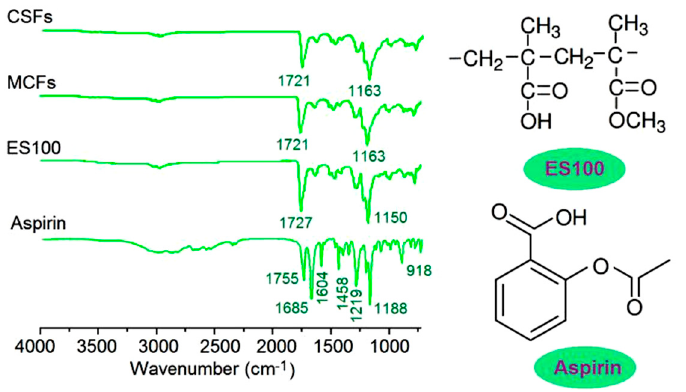
Figure 7. The ATR-FTIR spectra of the raw materials (aspirin and ES100) and also their nanofibers MCFs and CSFs from different electrospinning processes.